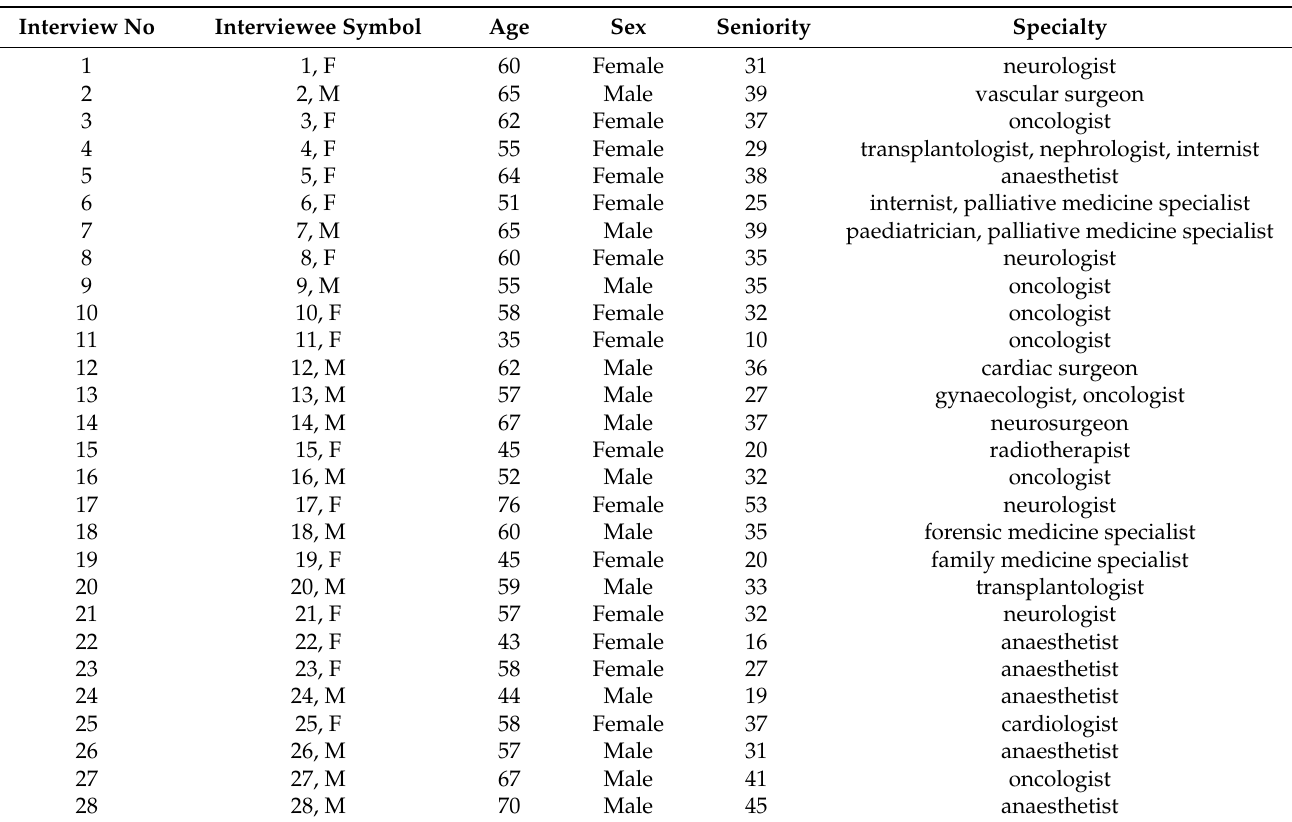
Table 1. Information on the